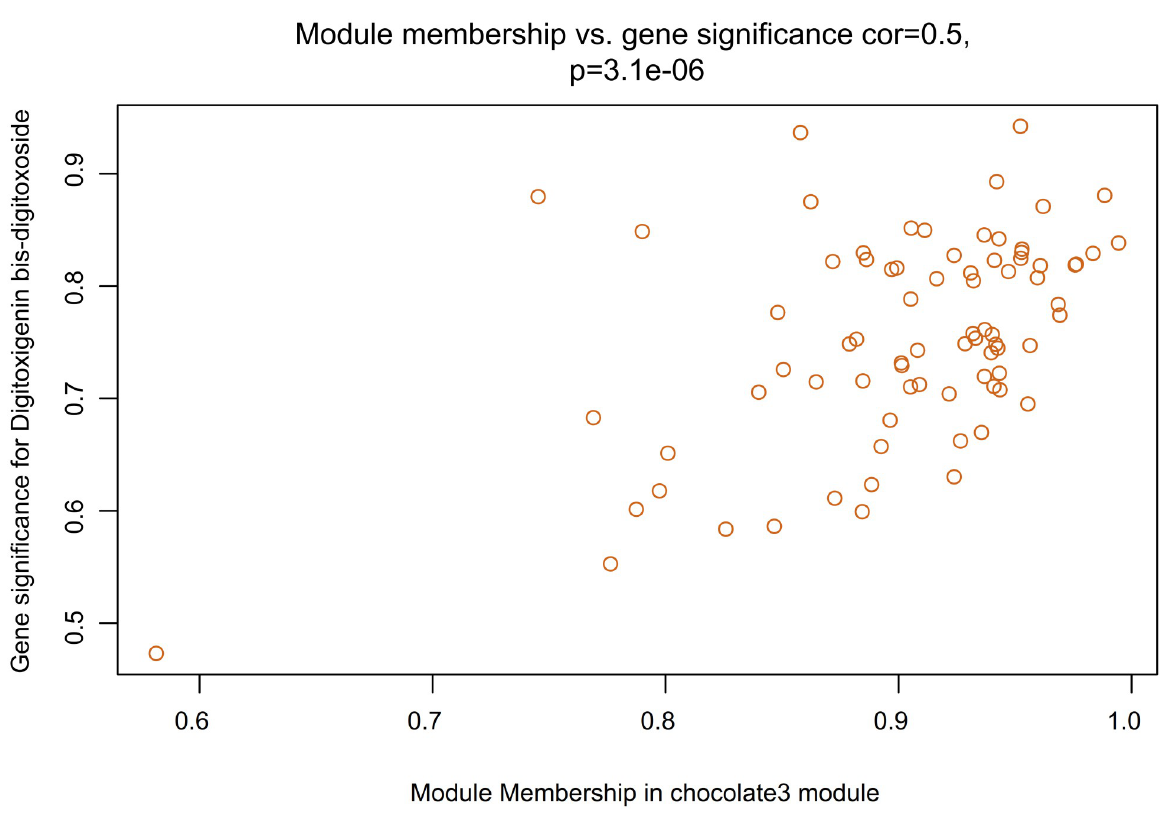
Fig 6. The scatterplot of Gene Significance (GS) for digitoxigenin bis-digitoxoside vs. Module Membership (MM) in chocolate3. The high significant correlation between GS and MM for Digitoxigenin bis-digitoxoside in the chocolate3 module.